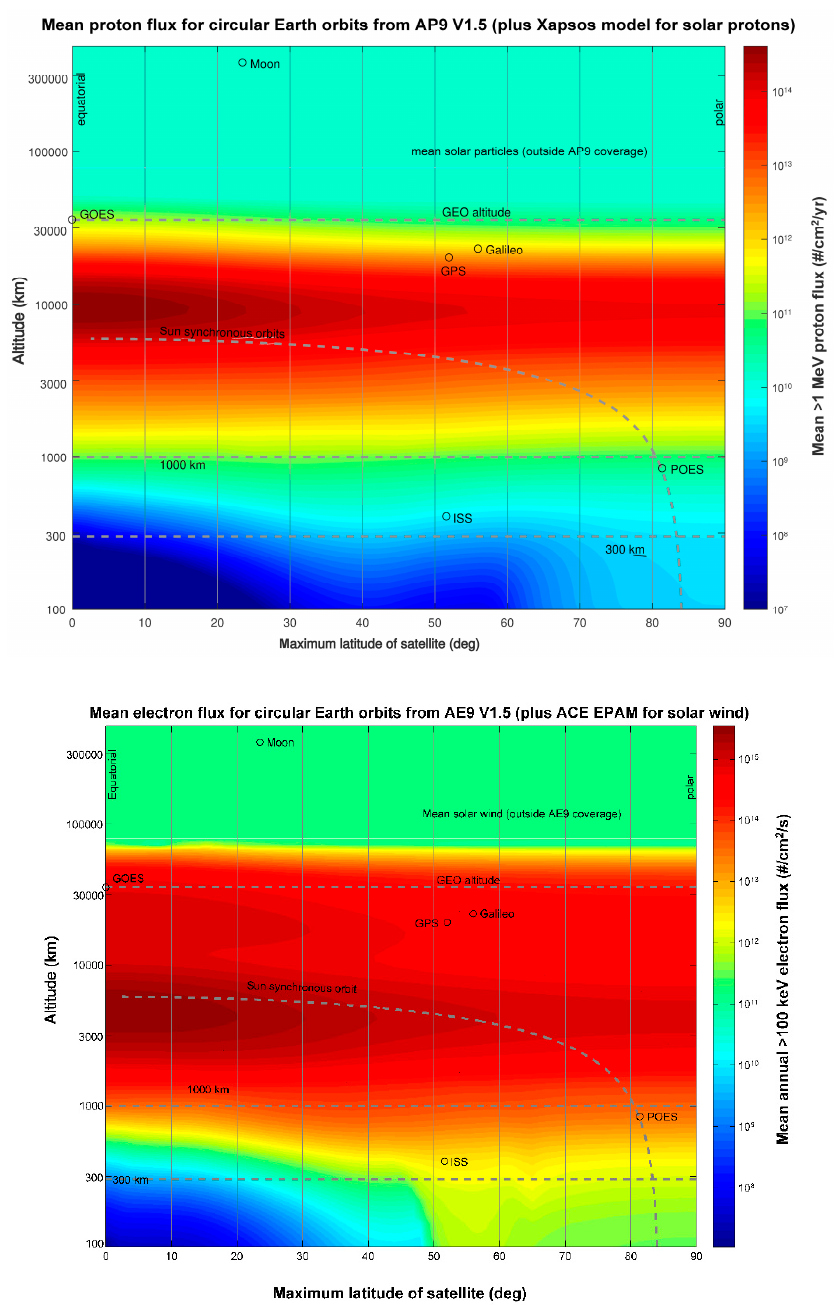
Figure 1. (Top panel) Mean annual electron flux ( > 100 keV electrons) and (bottom panel) mean annual proton flux ( > 5 MeV protons), orbit averaged, experienced by a satellite in a circular geocentric orbit as a function of altitude and maximum latitude (inclination for prograde orbits, supplement of inclination for retrograde orbits). Representative orbits are shown as dashed lines for reference, as are the positions of the Moon, International Space Station (ISS), and several other satellites. Figure based on AE9 V1.5 mean radiation belt model [22] for trapped electrons and protons, ACE EPAM data [22,23] for untrapped solar wind electrons, and the Xapsos model [24] for untrapped protons, with approximate geomagnetic cutoffs in solar proton access based on [25]. Kapton has been utilized for the spacecraft industry starting in the 1970s, and several attempts to summarize changes in its material properties, among those of other dielectrics, after interaction